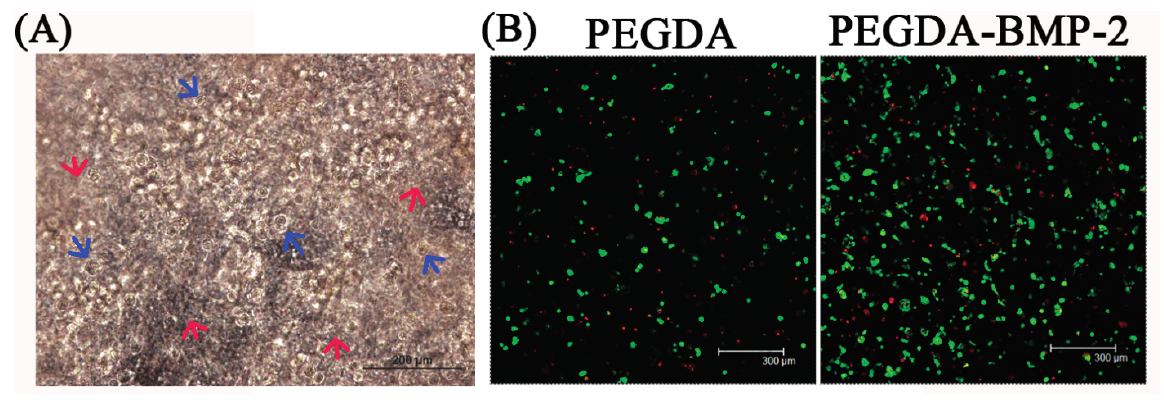
Figure 3. ( A ) Inverted light microscopy image (original magnification, 100×) of 0-day construct immediately after photoencapsulation of LF cells. Blue arrows: cells; red arrows: hydrogel; and ( B ) The LIVE/DEAD staining of LF cells cultivated into PEGDA or PEGDA-BMP-2 hydrogels for fourteen days by bioreactor culture after UV